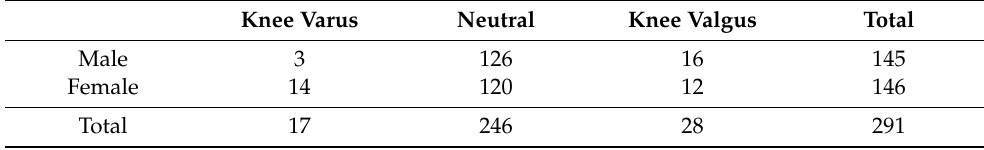
Figure 21. Gender difference in head movements in the frontal plane at the double support phase (right foot forward) (F value: 0.03, DF: 289, p -value: 0.04). Cross-tabulation analysis was conducted on the nominal gait parameters, i.e., left knee varus/valgus, right knee varus/valgus, foot varus/valgus, toe-in gait/toe-out gait, and pelvis abduction/adduction. Among them, we only examined gait parameters that may be considered meaningful with p -values less than 0.05 (Tables 7–9). Table 7. Cross tabulation analysis of right knee varus/valgus by gender (X 2 = 7.83, DF = 2, p -value =